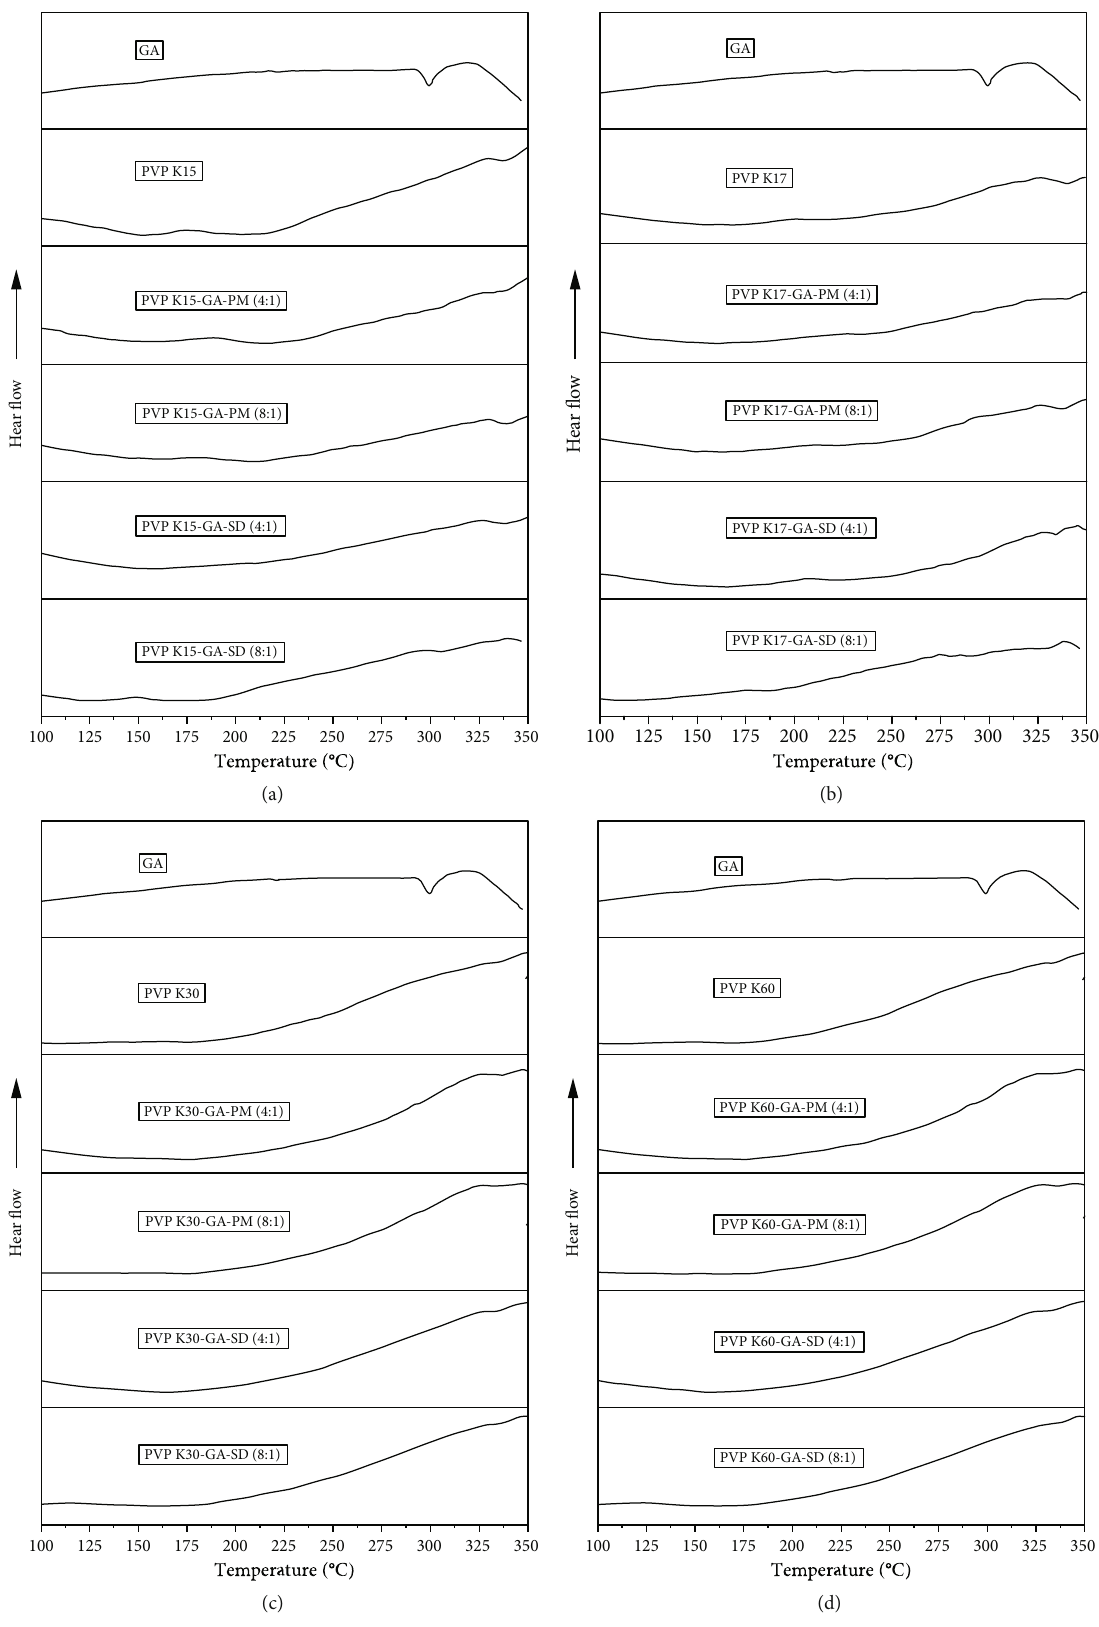
Figure 3: DSC curves of SDs and PMs of GA prepared using (a) PVP K15, (b) PVP K17, (c) PVP K30, and (d) PVP